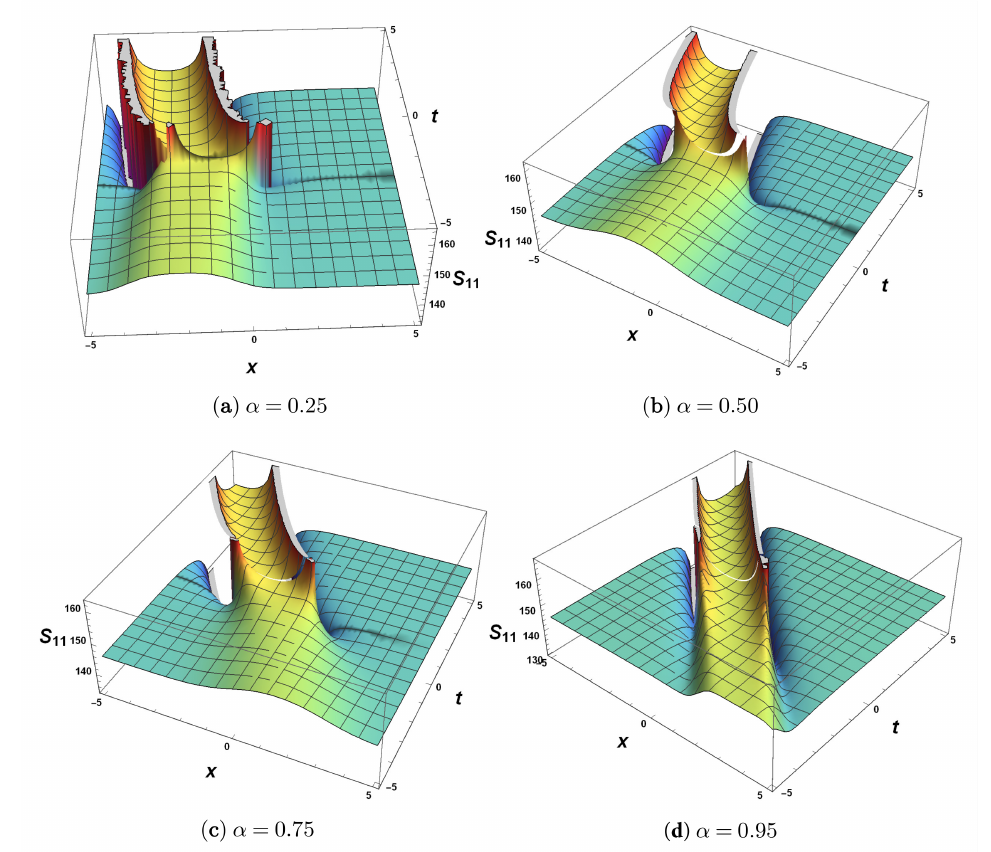
Figure 12. A 3D graphical representation for S 11